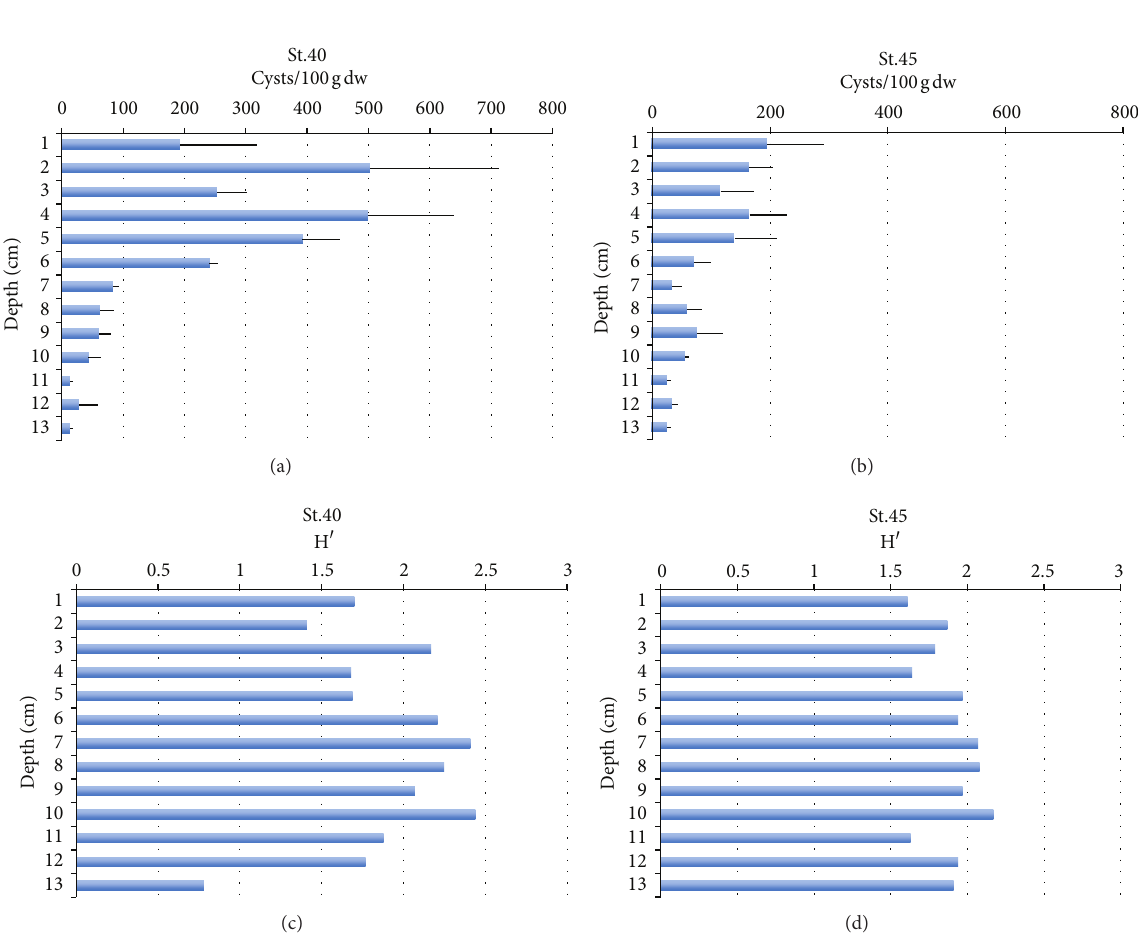
Figure 4: Resting stage abundance (average ± standard deviations) and Shannon’s index ( 𝐻 󸀠 ) values recorded for each cm layer of sediment cores collected at two investigated stations in Bay of Vlor¨e